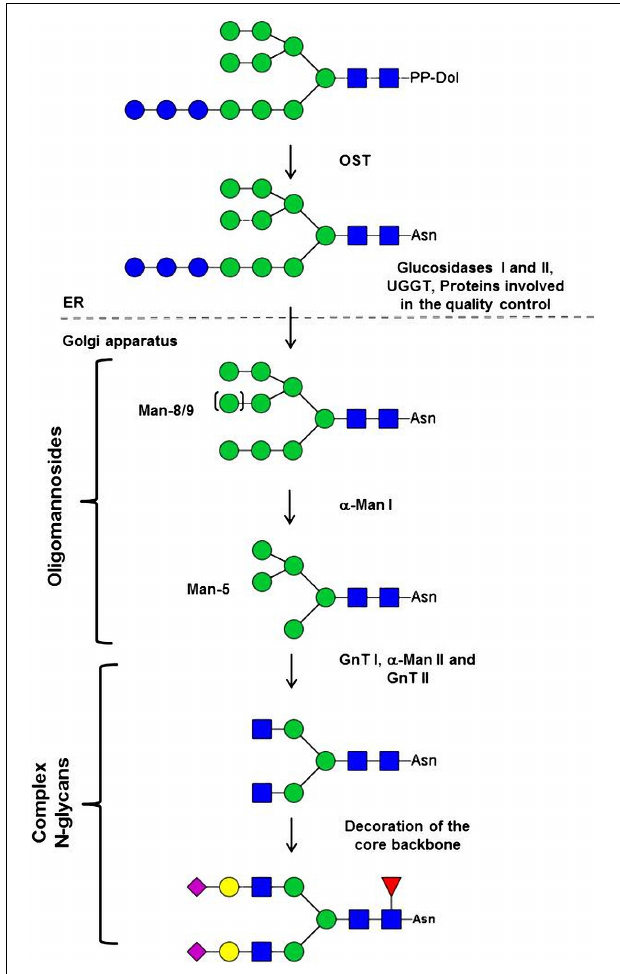
FIGURE 1 | Mammalian N -glycosylation pathway. This pathway starts in the endoplasmic reticulum (ER) and ends in the Golgi apparatus where the major maturation steps lead to sialylated and fucosylated biantennary protein N -linked glycans. The N -glycan structures presented here are annotated according to the symbolic nomenclature adopted by the Consortium for Functional Glycomics (Varki et al., 2009). PP-Dol: Pyrophosphate Dolichol; OST: oligosaccharyltransferase; Asn, asparagine; UGGT, UDP-glucose glycoprotein glucosyltransferase; α -Man, α -mannosidase; GnT, N-acetylglucosaminyltransferase; Man-8/9, oligomannoside bearing 8/9 mannose residues; Man-5, oligomannoside bearing 5 mannose